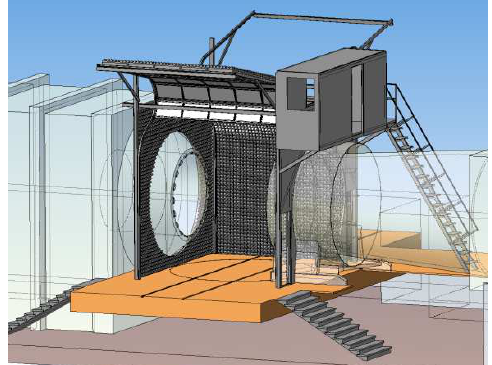
Fig. 2. Wind tunnel with anechoic chamber .